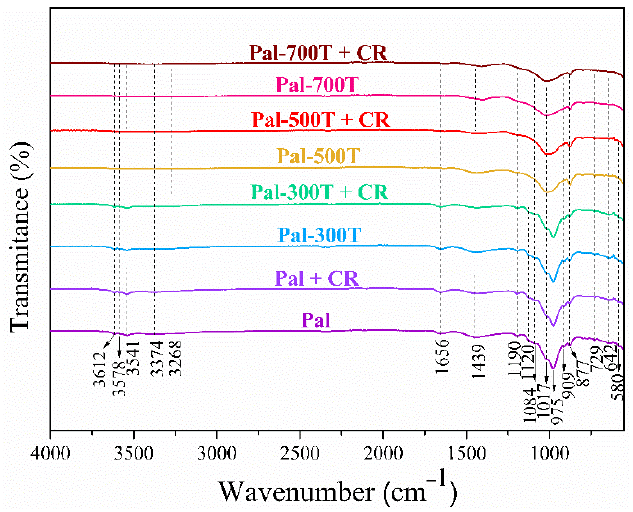
Figure 12. FTIR spectra of samples before and after CR adsorption.